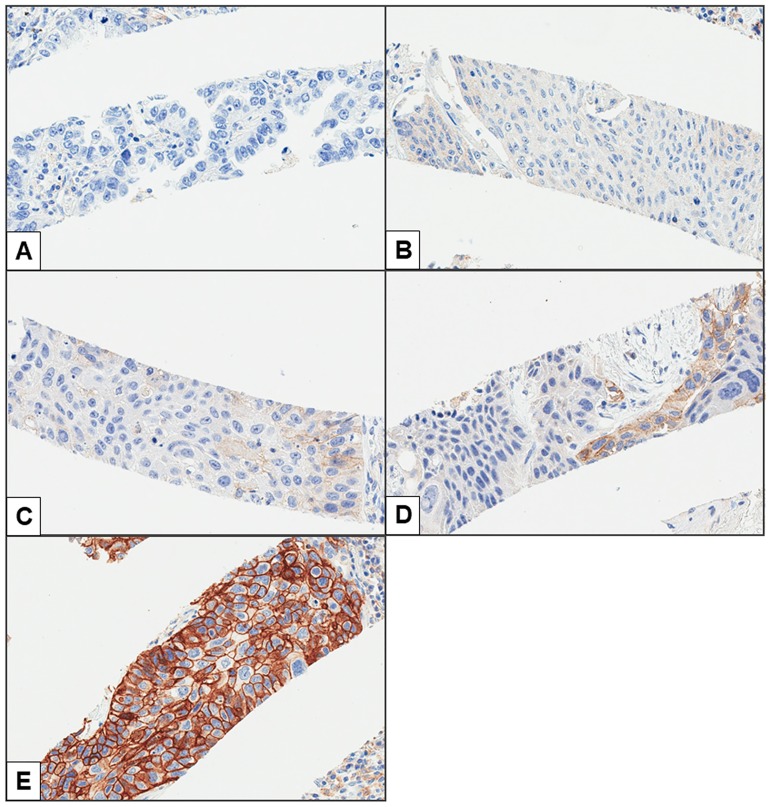
Representative images of PD-L1 expression.(A) <1.0%, (B) 1.0–4.9%, (C) 5.0–9.9%, (D) 10.0–49.9%, and (E) ≥50.0% PD-L1-positive cells (magnification, 200×).